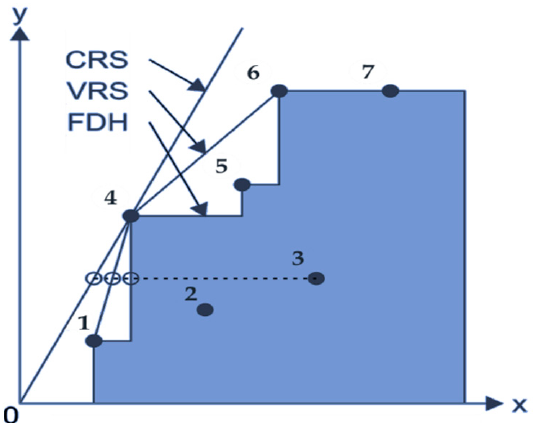
ture are identified. The production possibility set of the FDH model is accomplished by the relationship between the CRS, VRS and FDH models.